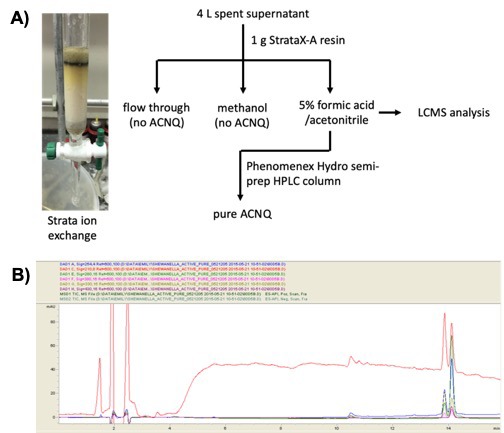
Purification scheme of ACNQ from spent supernatant.(A) Optimized workflow for the purification of ACNQ. Cultures were grown for 72 hr under aerobic conditions at 30°C, 0 rpm. The cells were pelleted by centrifugation (7,000 rpm, 30 min) and the supernatant passed through a 0.22 μm filter. The pH of the sterile supernatant was adjusted to 6.5 and then was passed through 1 g of StrataX-A resin. ACNQ was eluted from the column with 15 mL of 5% formic acid/acetonitrile. This material was then processed on Phenomenex Hydro semi-prep HPLC column where pure ACNQ eluted around 33 min. (B) HPLC UV/Vis chromatogram of the reduced complex fraction used for analysis HR-q-TOF-MS. Three main metabolites can be visualized with UV/Vis - ~ 10.5, 13.9, and 14.1 min. ACNQ was the third metabolite.